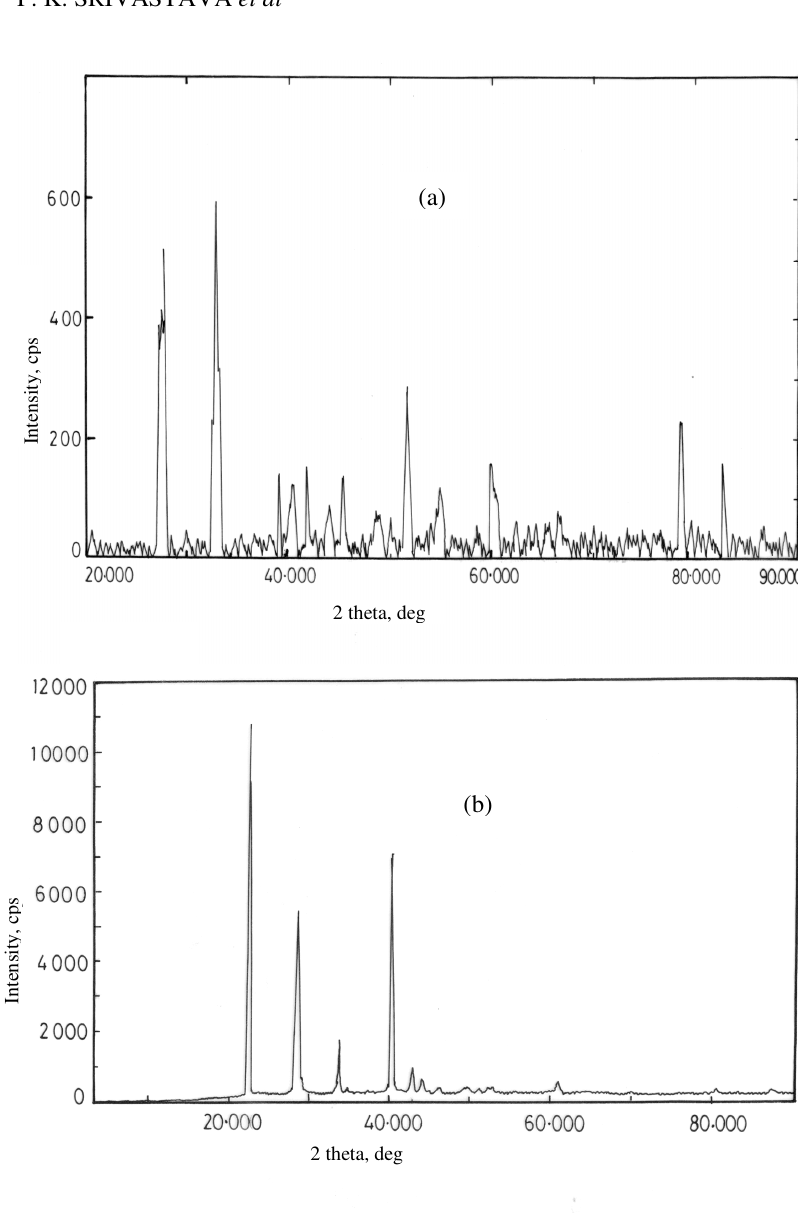
Figure 7 . X-ray powder spectrum of trees / bushes pattern material along with X-ray powder spectrum of succinic. (a) Pattern material (b) Succinic acid. Mechanism of